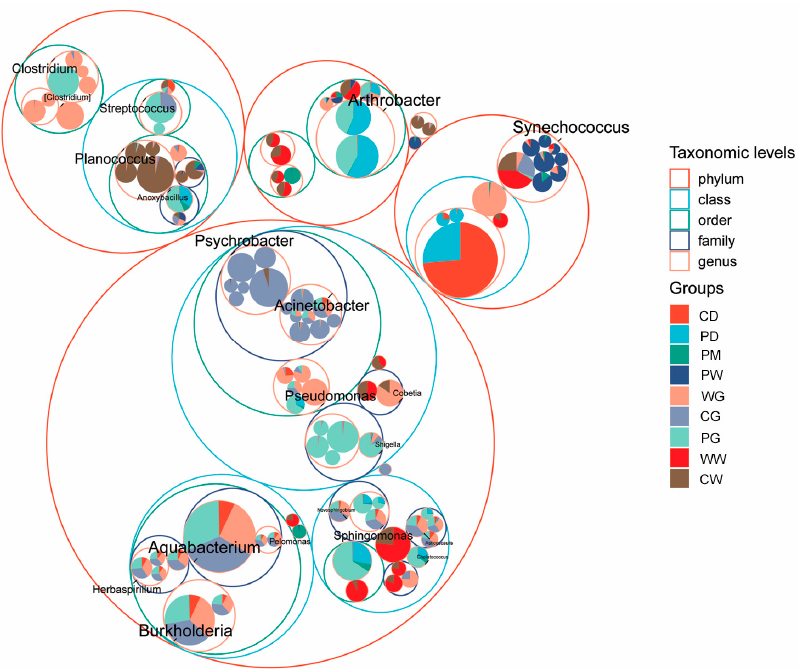
Figure 4. Taxonomic tree showing the microbial community associated with A. schlegelii gut, diet, and environmental compartments in different living habitats. The largest circles represent the phylum level, and the inner circles represent class, family, and genus. The circle sizes represent the mean relative abundance of the differentially abundant taxa. The sector area within a circle indicates the abundance of the taxon (top 100) to which the circle corresponds.